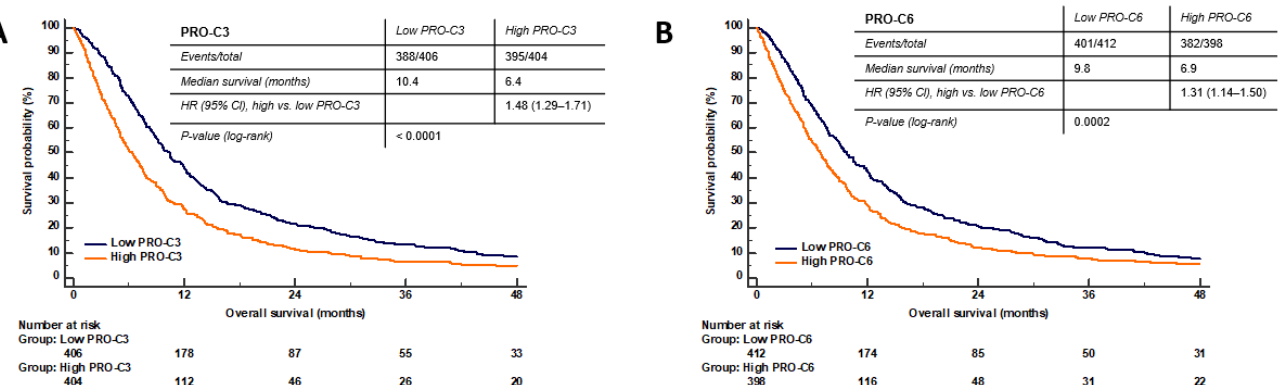
Table 2: Uni- and Multivariate Analysis (Overall Survival), n = 810